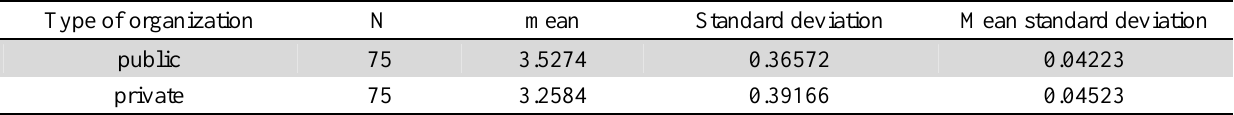
Mean and standard deviation of the managers of public and private organizations' attitudes in terms of social